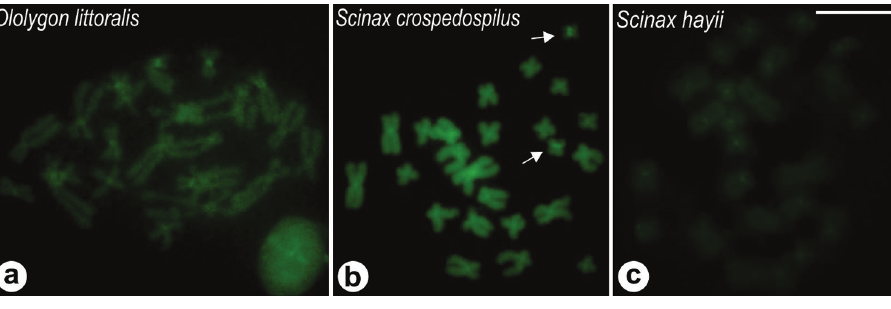
Figure 7. Cromomycin A staining in Ololygon and Scinax species. a O. littoralis b S. crospedospilus c S . hayii . 3 NOR-bearing chromosomes in b (arrow). Bar = 10